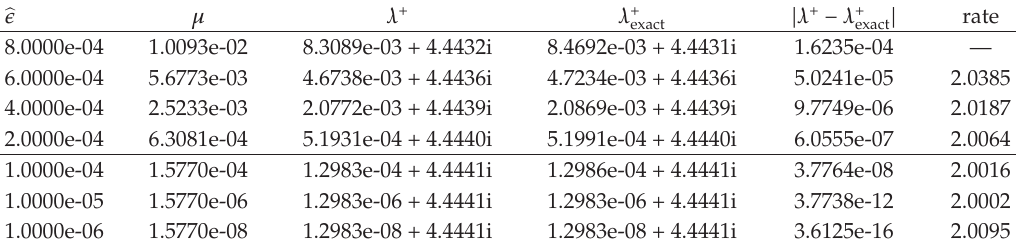
Table 1: FHN eigenvalues. The rate corresponds to the convergence of λ (cid:9) (cid:8) iω 0 (cid:9) λ μ μ towards λ (cid:9) respect to μ